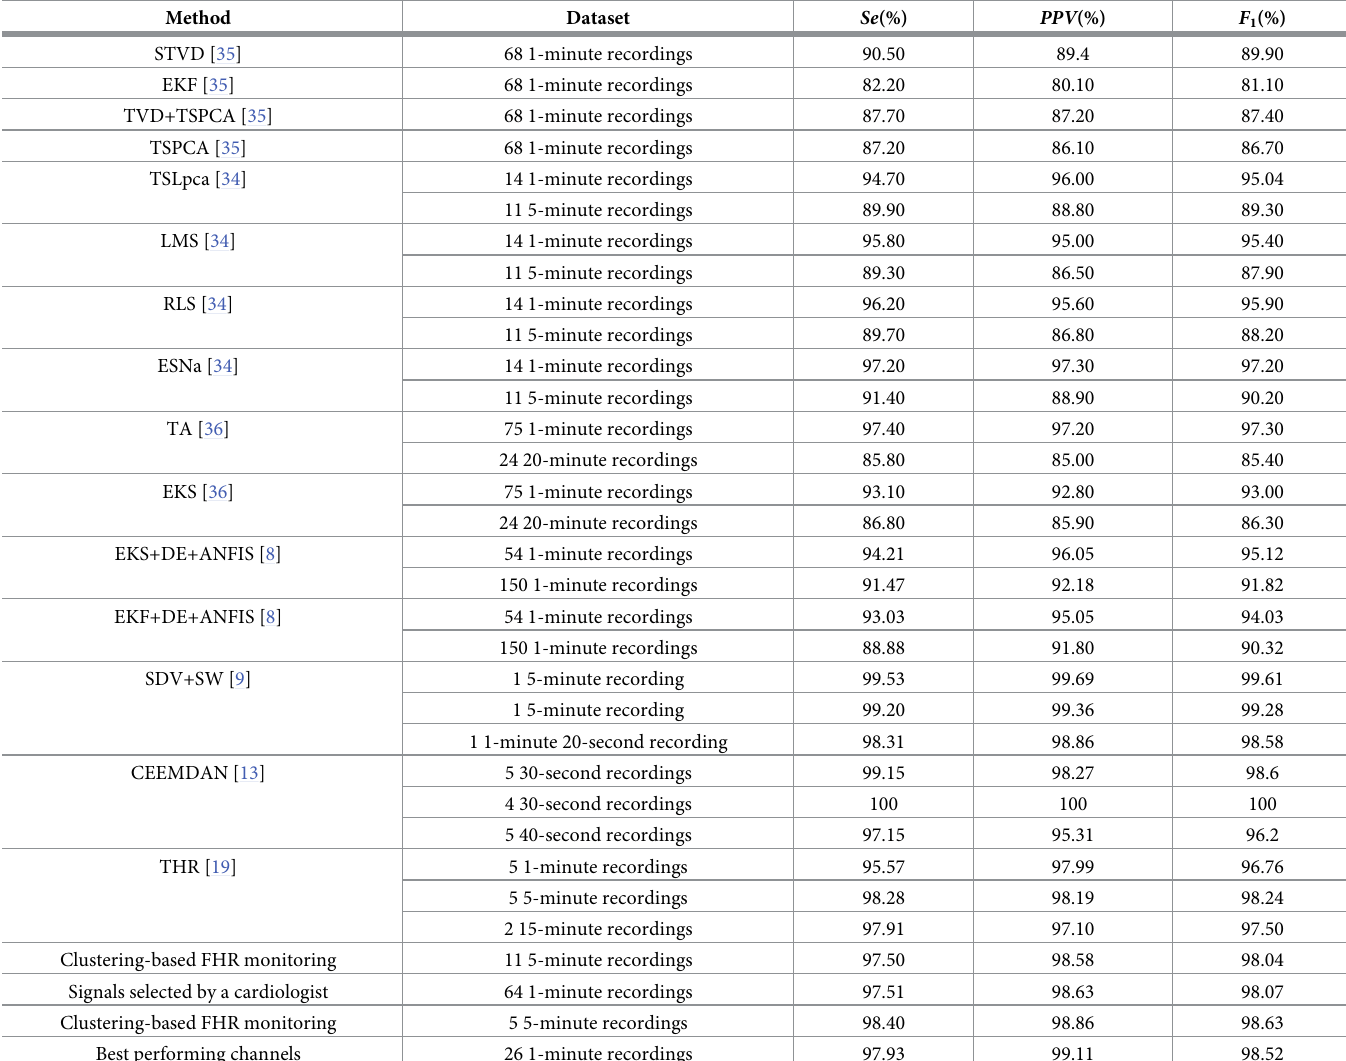
Table 3. Comparison of the results of different FHR extraction